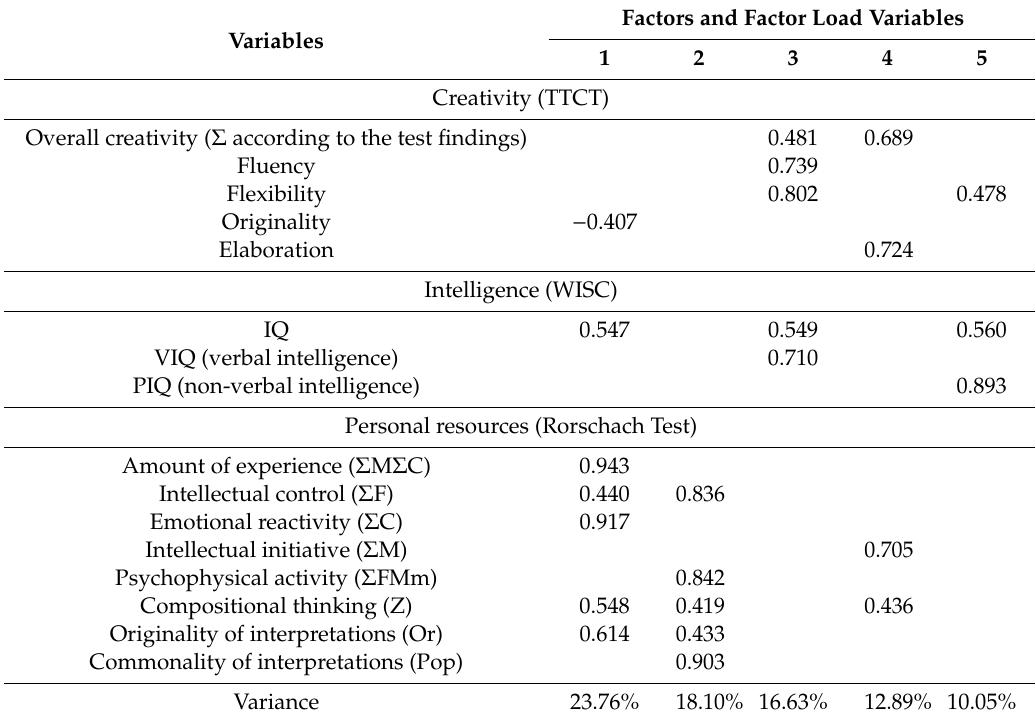
Table 4. Structure of children’s creativity, intelligence, and personal resources, Group 2.